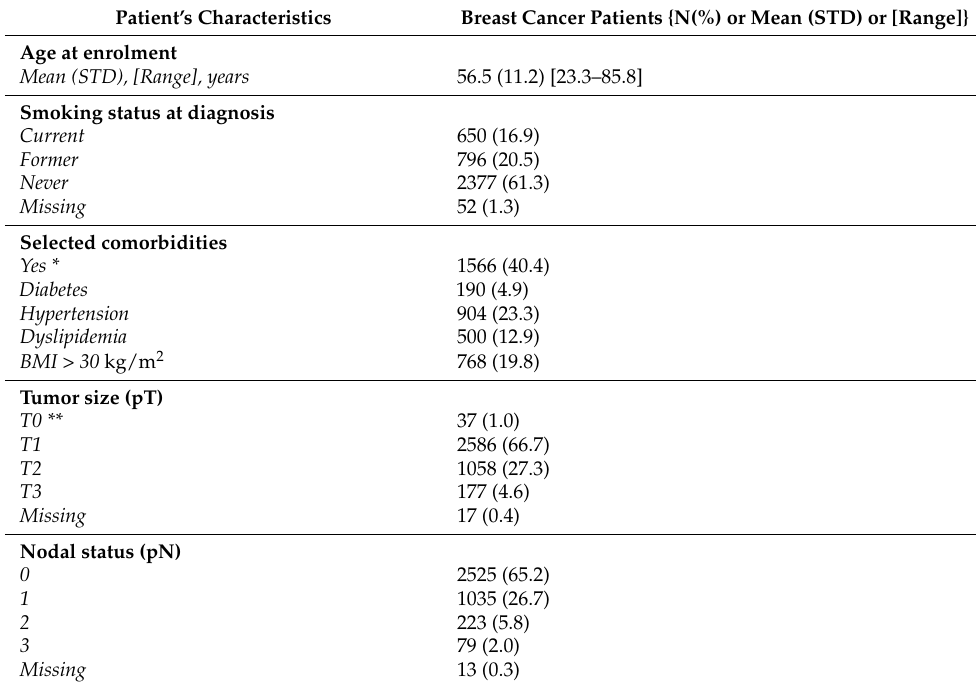
Table 1. Characteristics of the CANTO-RT